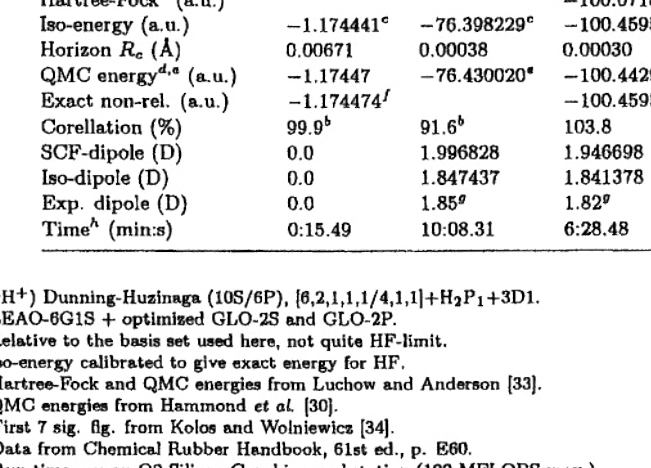
Figure 22: A reproduction of Table 4.2 of Ref. [52] presenting the first known exact representation of the experimental data of the hydrogen molecule via isomathematics and isochemistry, by providing an experimental confirmation of the validity in molecu- lar structres of Einstein’s determinism according Lemma II-3.7, with a convergence of the isoperturbative series at least one thousand times faster than conventional series, by therefore providing an experimental confirmation of Corollary II-3.7.1.